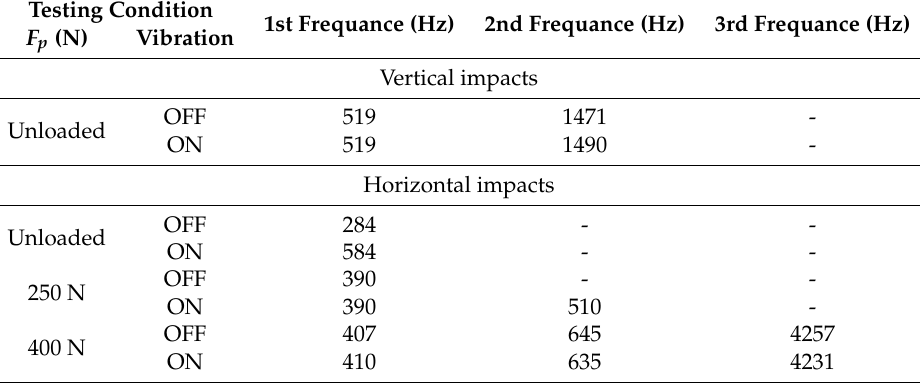
Figure 5. Frequency response functions (FRF) and Bode diagram obtained by AH accelerometer after impact test on the UVABB tool: unloaded and vibrations ON. Table 4. Natural frequencies obtained through impact tests on the UVABB